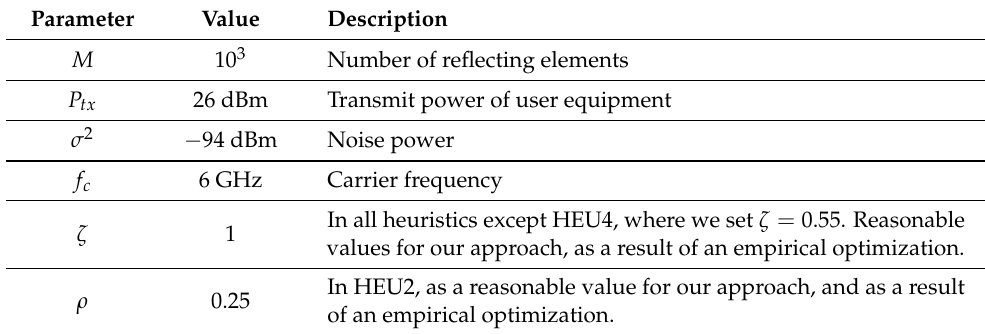
Table 1. Parameters for numerical